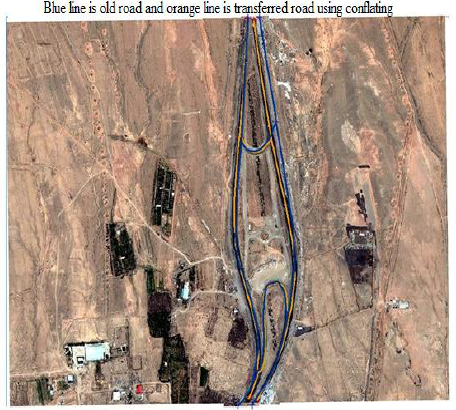
Figure 4: Vector-image conflation using Rubber-Sheeting method